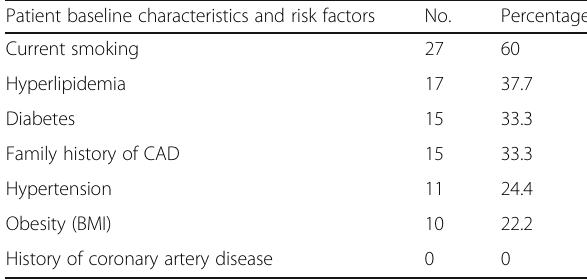
Table 1 Patient baseline characteristics and risk factors Patient baseline characteristics and risk